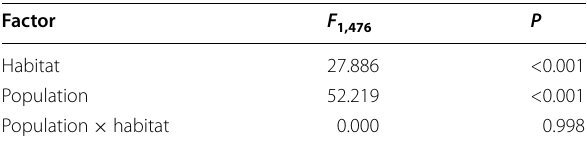
Table 1 Results of the linear mixed model test of the effects of habitat (forested vs. open patch) and population on display size in H . ventricosa